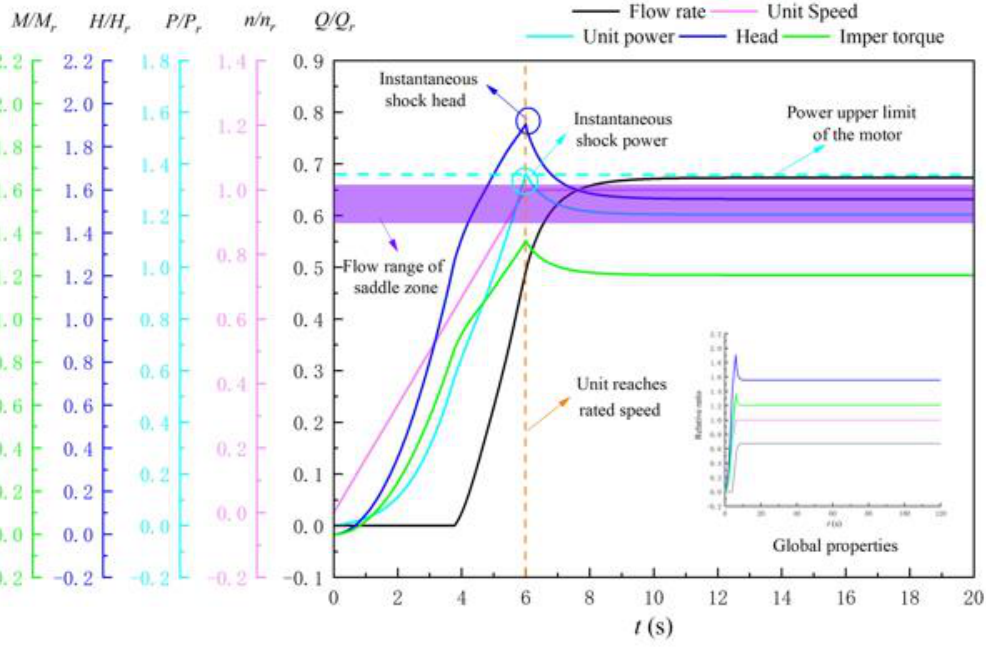
Figure 23. Start-up characteristics curve of LAPS equipped with FLVA (15.0% A g ) and OVHO (1.27 H m ) under gate refusal working conditions.